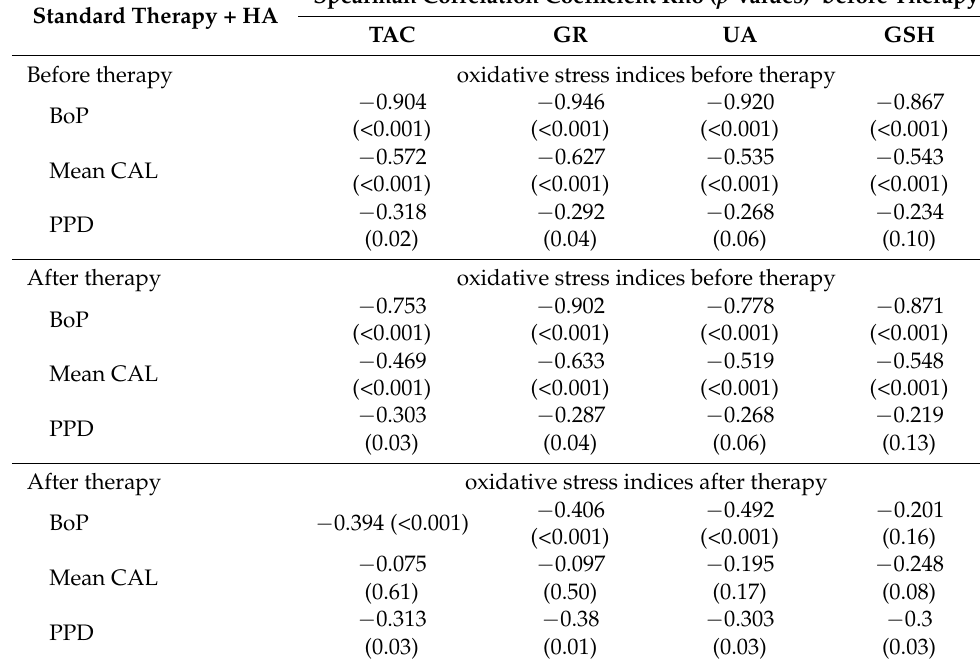
Table 5. Correlation between the parameters of oxidative stress and periodontal indices in patients with standard therapy +